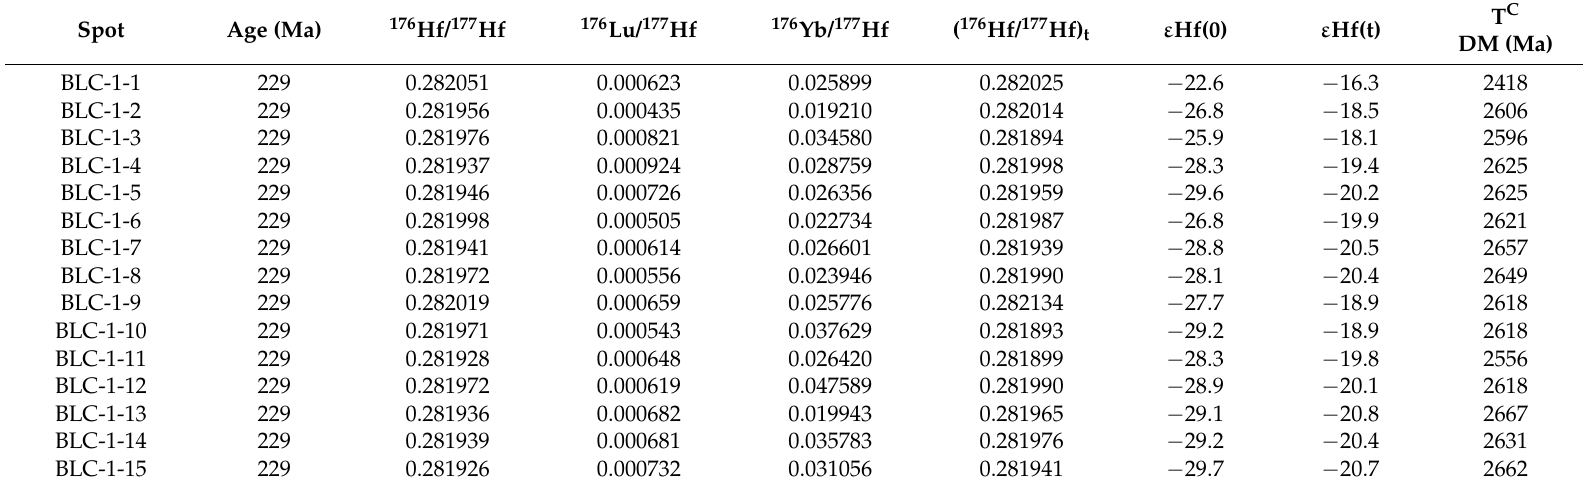
Table 2. Zircon Lu–Hf isotopic compositions of the